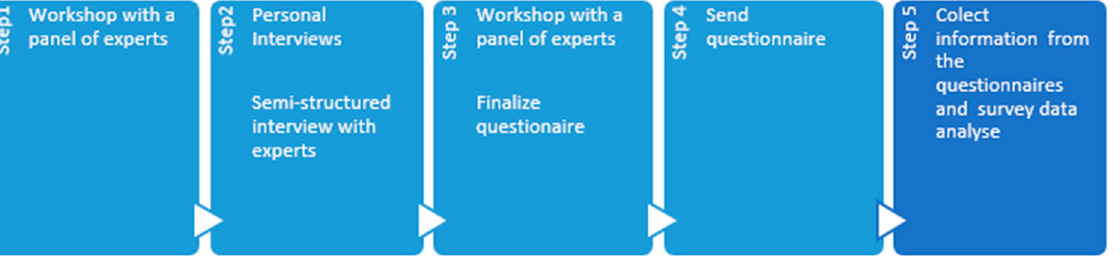
Figure 3. Five step methodology. Figure 3. Five step